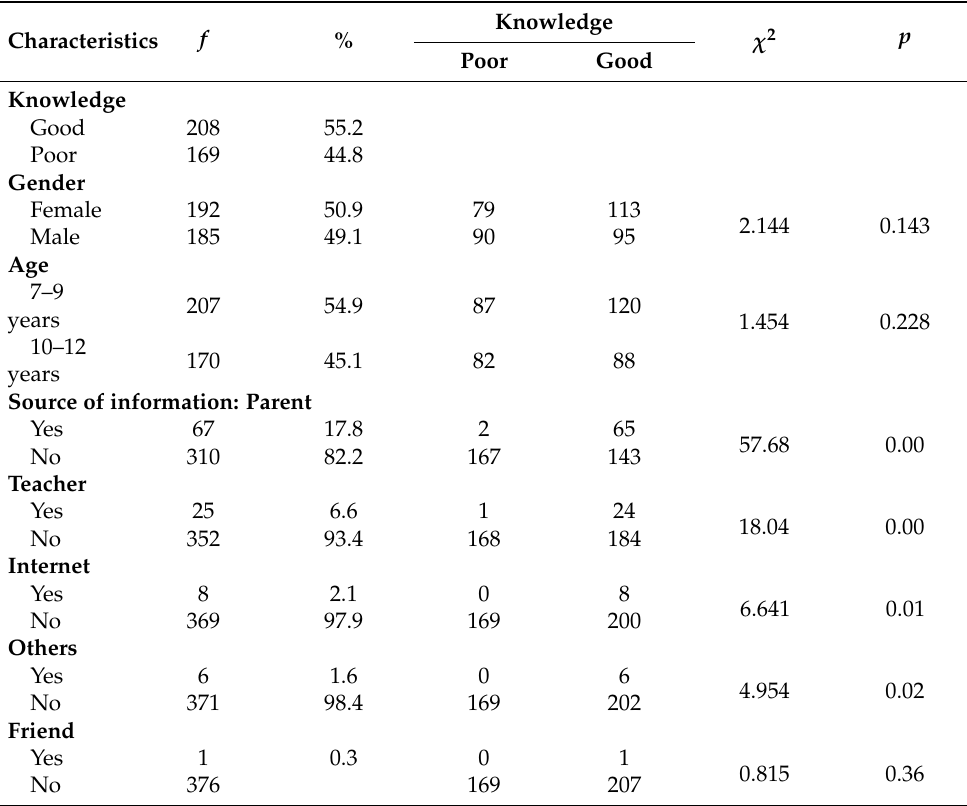
Table 1. Respondents’ characteristic and bivariate analysis of prevention of children sexual abuse in Bandung Regency (n =